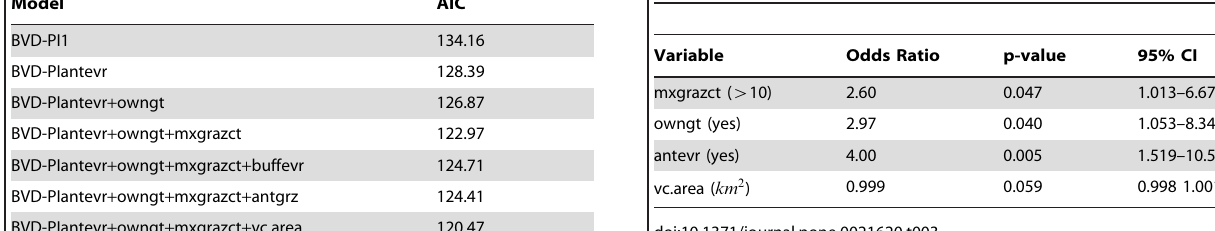
Table 3. Final risk factor model for presumed BVD PI in the herd for cattle herds in the Adamawa Region of Cameroon (n=138 herds; 4 herds with missing values for mxgrazct